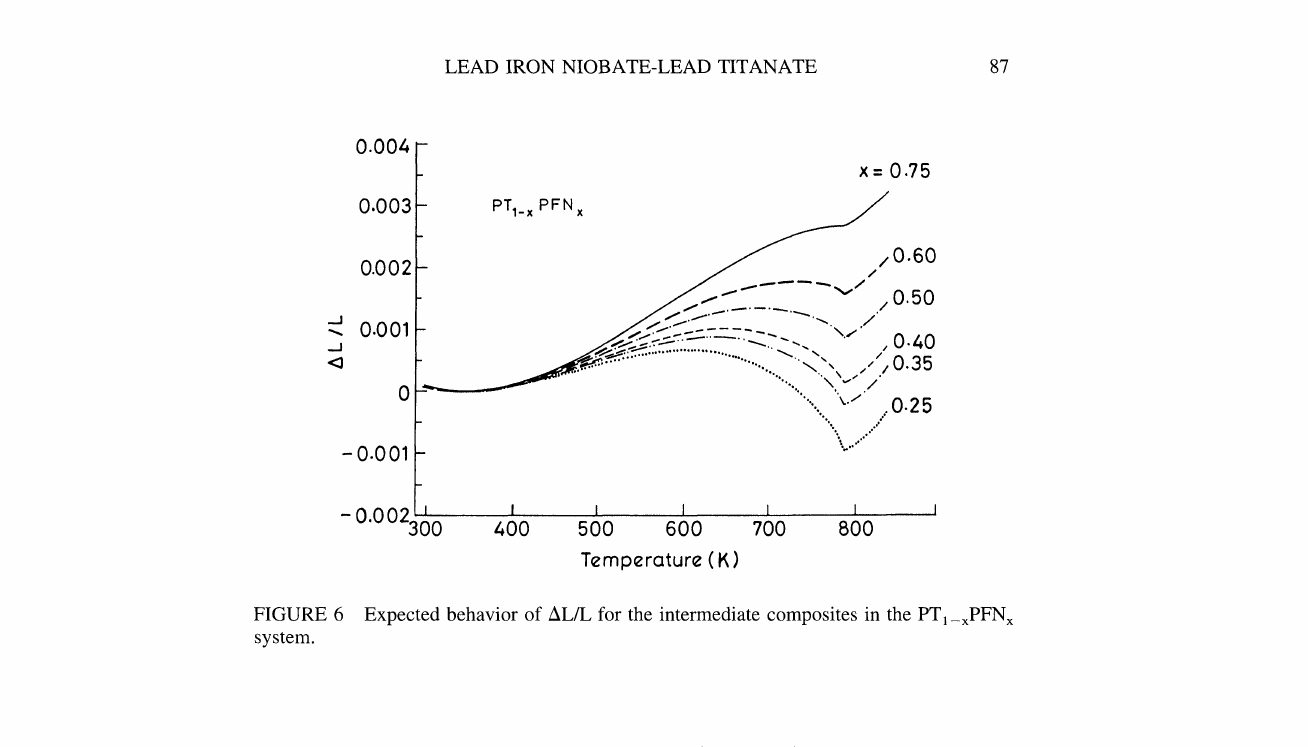
peaks are not well resolved. The pattern of composites C2-1253 and C3- 1253 indicate crystallization of a single-phase solid solution corresponding to a c/a ratio of 1.0315 and 1.0414, respectively. The peaks are broad and spectra are noisy due to insufficient heating time and poor